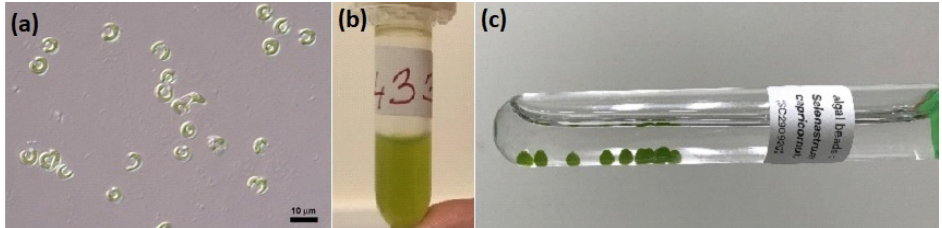
Figure 1. Used forms of Raphidocelis subcapitata (formerly Selenastrum capricornutum ): ( a ) culture SKULBERG 1959/1 (CCALA 433) [36]; ( b ) living (free) inoculum; ( c ) immobilized algal beads.